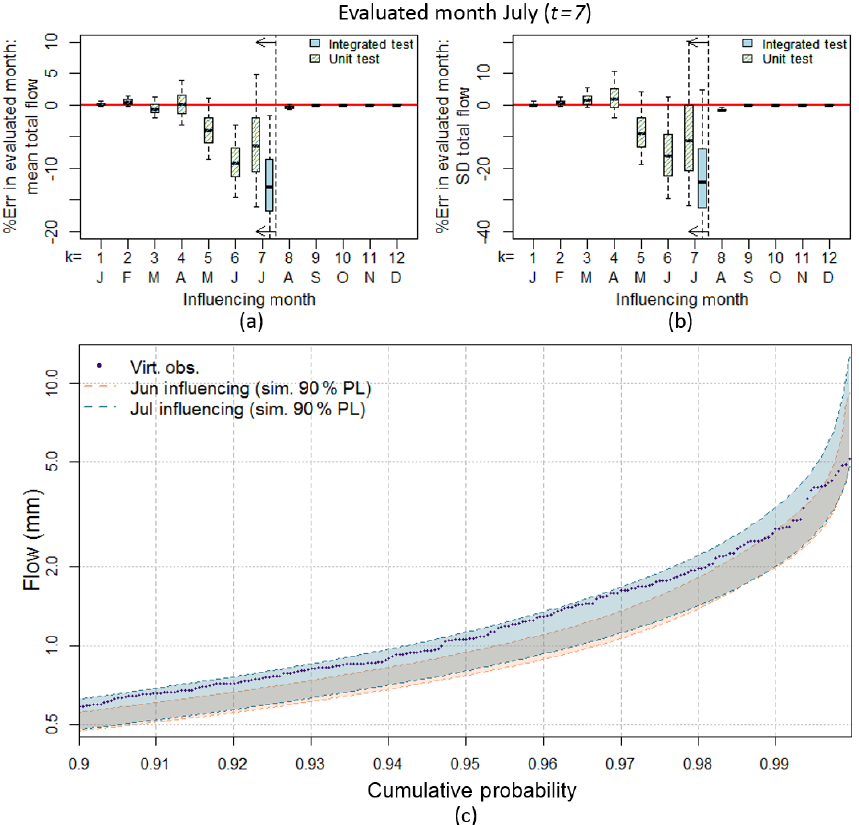
Figure 12. Happy Valley, Site 10 (a) unit test error in mean monthly flow (July), (b) unit test error in standard deviation of monthly flow (July), and (c) July flow duration curve when June and July are selected as influencing months in the unit test (top 10% of flow days shown). Boxplot whiskers indicate the 90% limits of the simulated streamflow